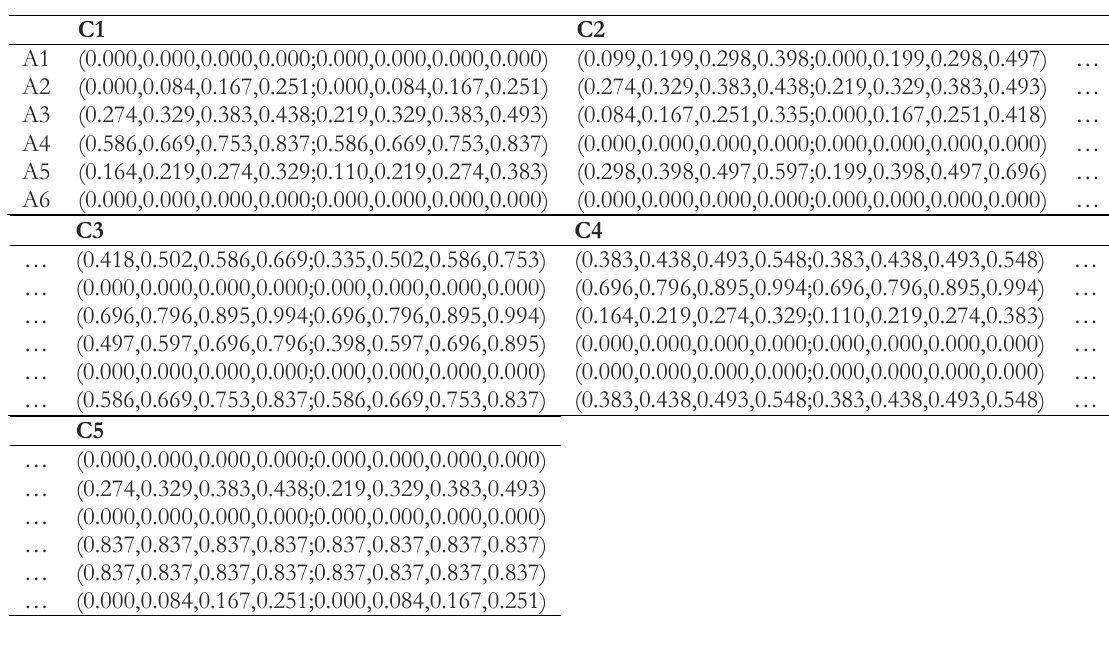
Table 6. Converted IFN of preferences for Expert 1.